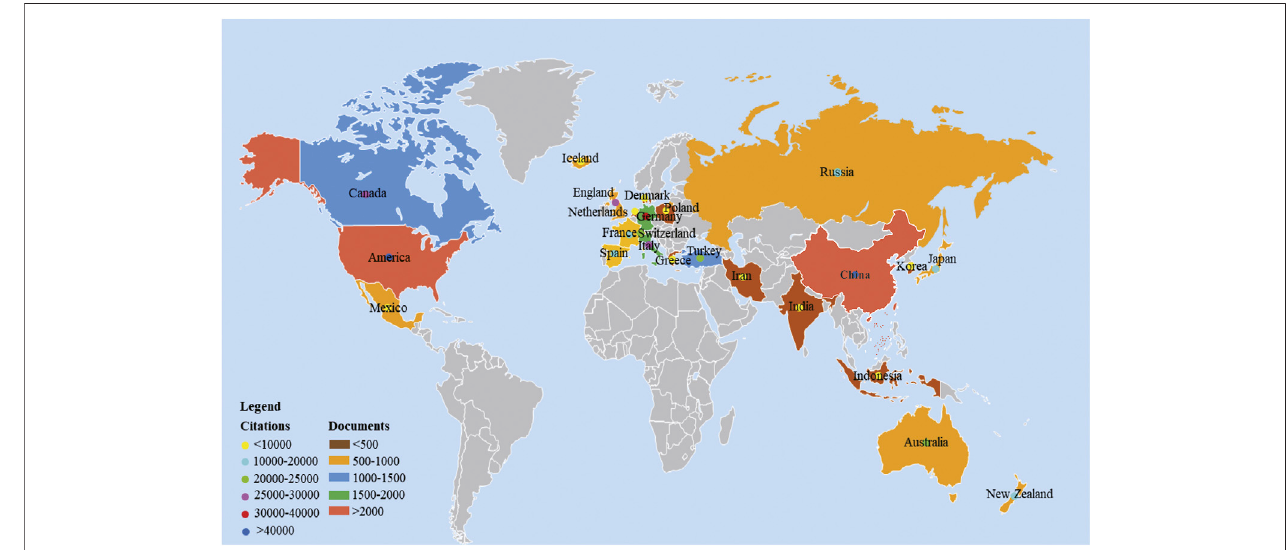
FIGURE 4 | Country distribution of the